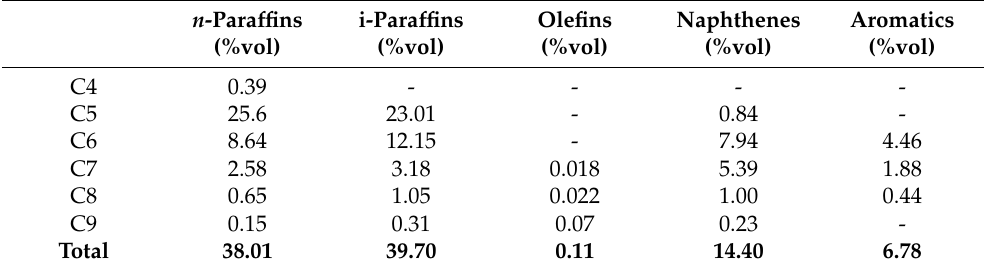
Table 3. Example of the PIONA analysis result, adapted from references [22,25–27].